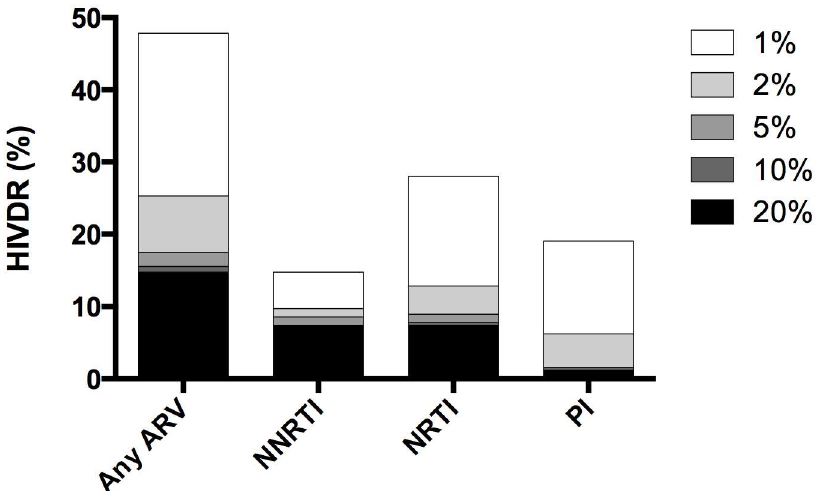
Fig 1. PDR levels at different sensitivity thresholds. PDR levels were estimated at 20%, 10%, 5%, 2% and 1% sensitivity thresholdsusing next generation sequencing as explainedin Methods. Drug resistance was defined as the presence of any surveillancedrug resistance mutations at the specified sensitivity